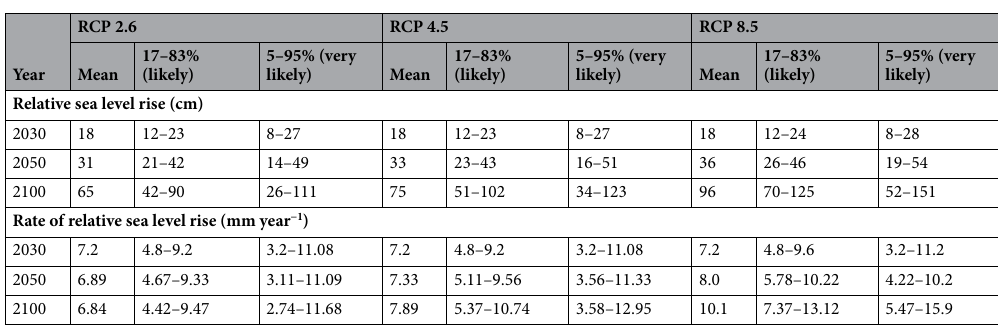
Table 1. Estimated coastal relative sea level rise (cm) and its rate (mm year −1 ) in the Haikou area under different GHG emission scenarios (data from Kopp et al . 24 ). Local settling rate: 1.09 ± 3.22 mm year −1